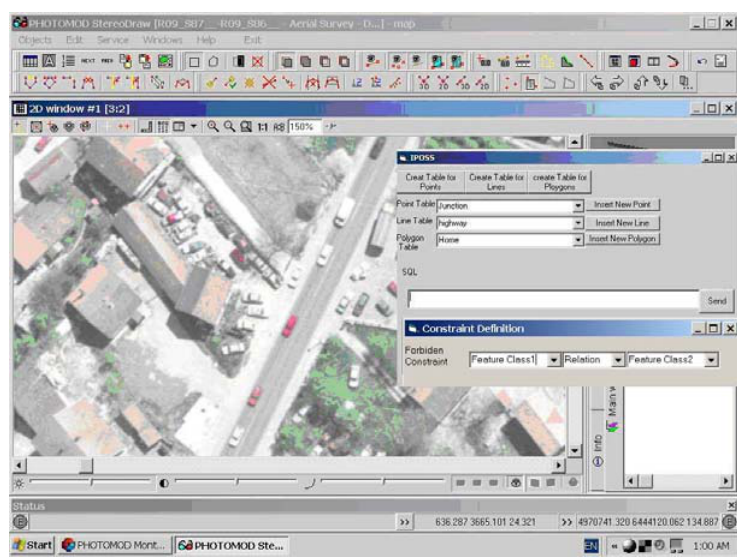
Figure 6. User interface of IPOSS in PhotoMod